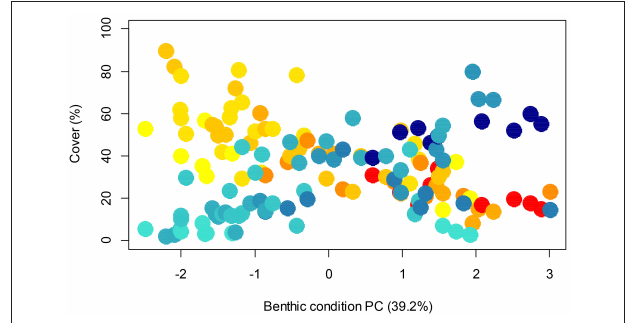
FIGURE 5 | Relationship between the benthic condition PC (benthic PC1), reef builders (blue) and algae (yellow-red) showing all transects with greater distance from shore indicated by darker colors. This shows the opposing relationship of the two benthic groups with benthic PC1.